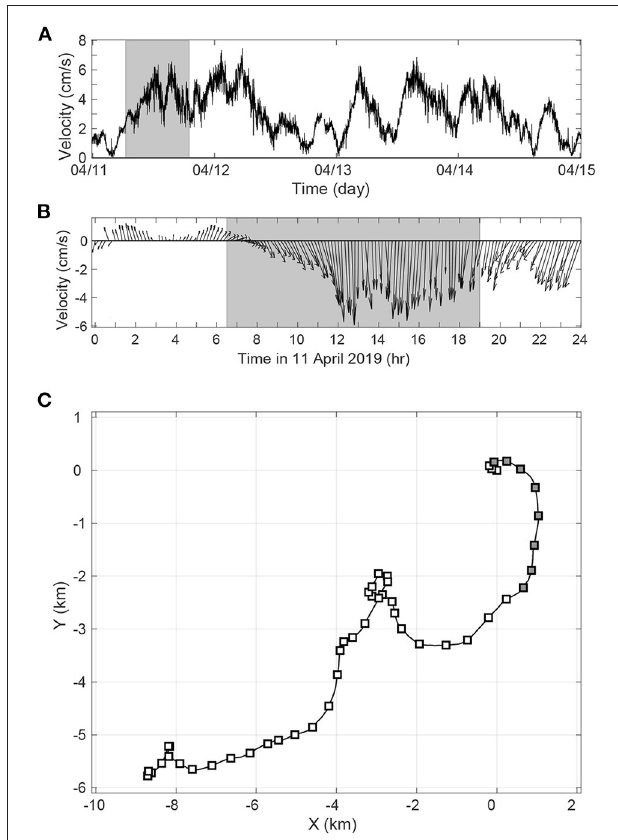
FIGURE 3 | (A) Current velocity measurements at station PFM06 at 1 m asf from 11 to 15 April 2019. The dredging period is marked in grey. (B) Feather plot of the current velocity measurements at the same station on 11 April with a time interval of 10 min. (C) Progressive vector diagram (PVD) of the deep-sea currents observed at the same station at 1 m asf starting on 11 April 2019. Squares mark 2-hourly time intervals, those corresponding with the dredging period are coloured in grey. The displacements in x and y directions are shown in